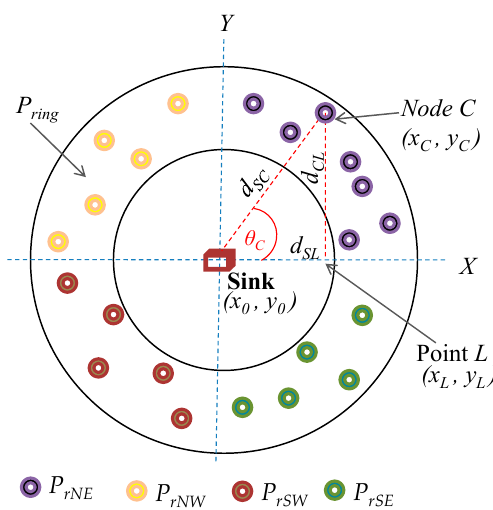
Figure 3. Computation of the inclination angle θ .